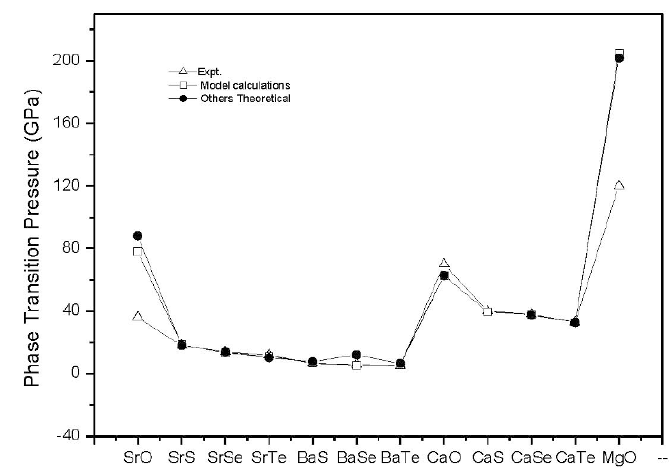
Figure 8. Phase transition pressure of alkaline earth chalcogenides.